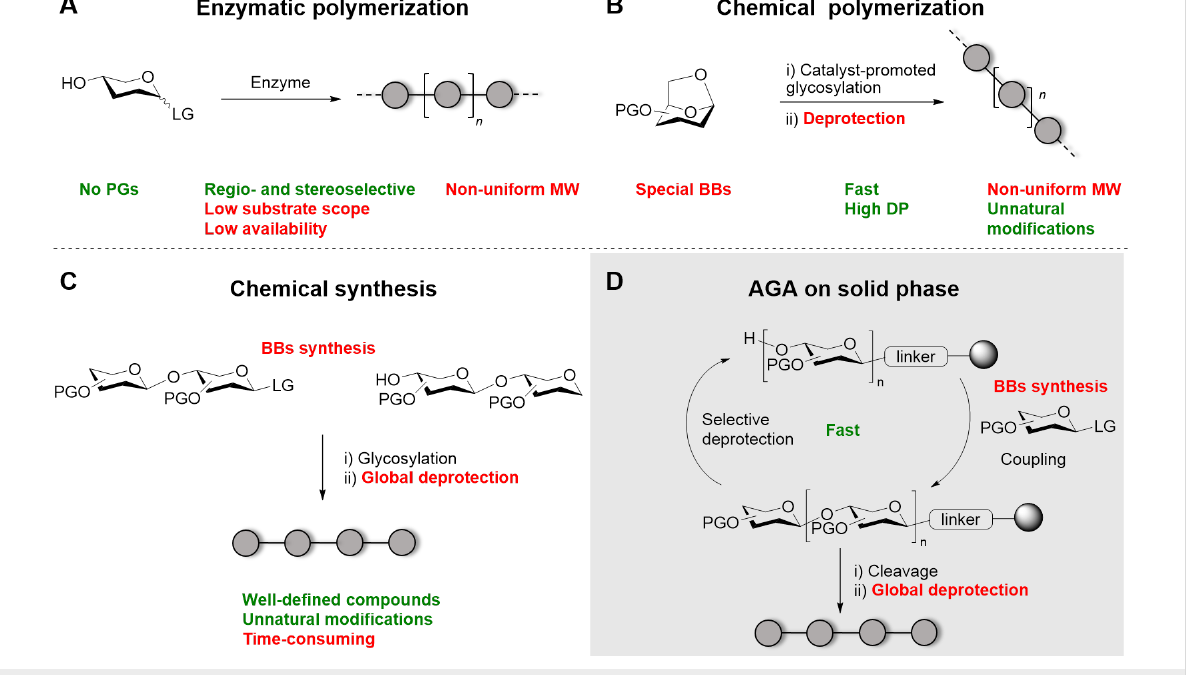
Figure 1: Overview of the methods available for the synthesis of polysaccharides. For each method, advantages (green) and disadvantages (red) are highlighted. Polymerization techniques (A and B) generate mixtures of compounds with non-uniform distribution of molecular weight (MW). In contrast, chemical synthesis (C) produces well-defined polysaccharides, but it is time-consuming. Automated Glycan Assembly (AGA) increases the efficiency of chemical synthesis by automating cycles of coupling and deprotection on a solid support